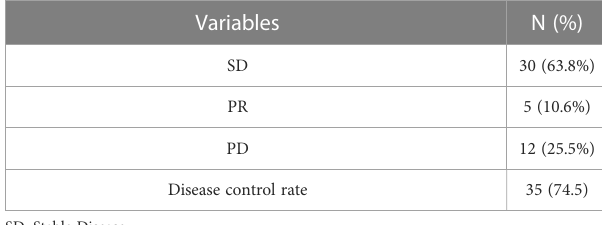
TABLE 2 Clinical ef fi cacy after the oncolytic virus injection.